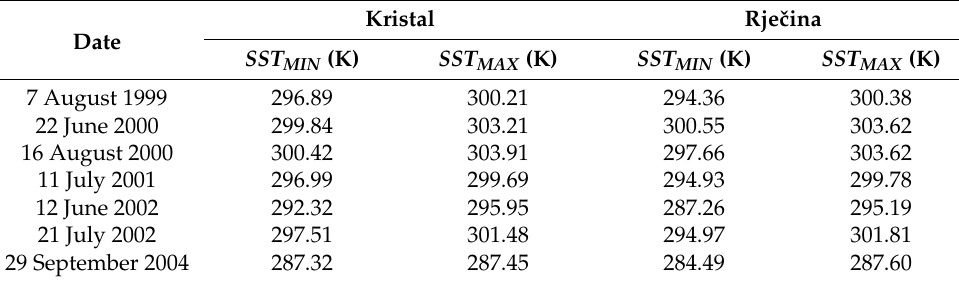
Table 3. Minimum and maximum SST at the outlet locations.